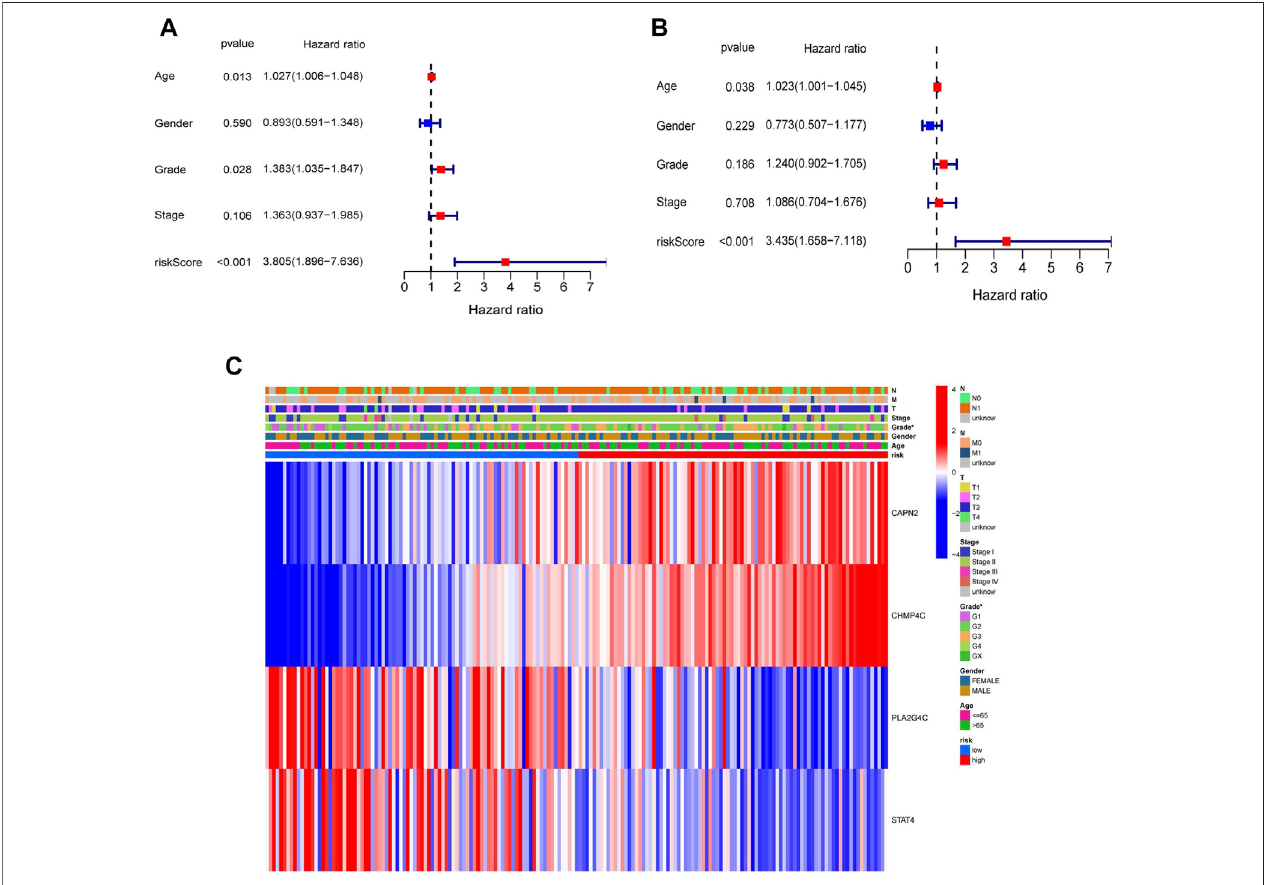
FIGURE 6 | Univariate and multivariate Cox regression analyses for the risk score and clinical features in the TCGA cohort. (A) Univariate Cox regression analysis. (B) Multivariate Cox regression analysis. (C) Heatmap with the correlation between the expression of four NRGs in different risk groups and clinical features (* p < 0.05).